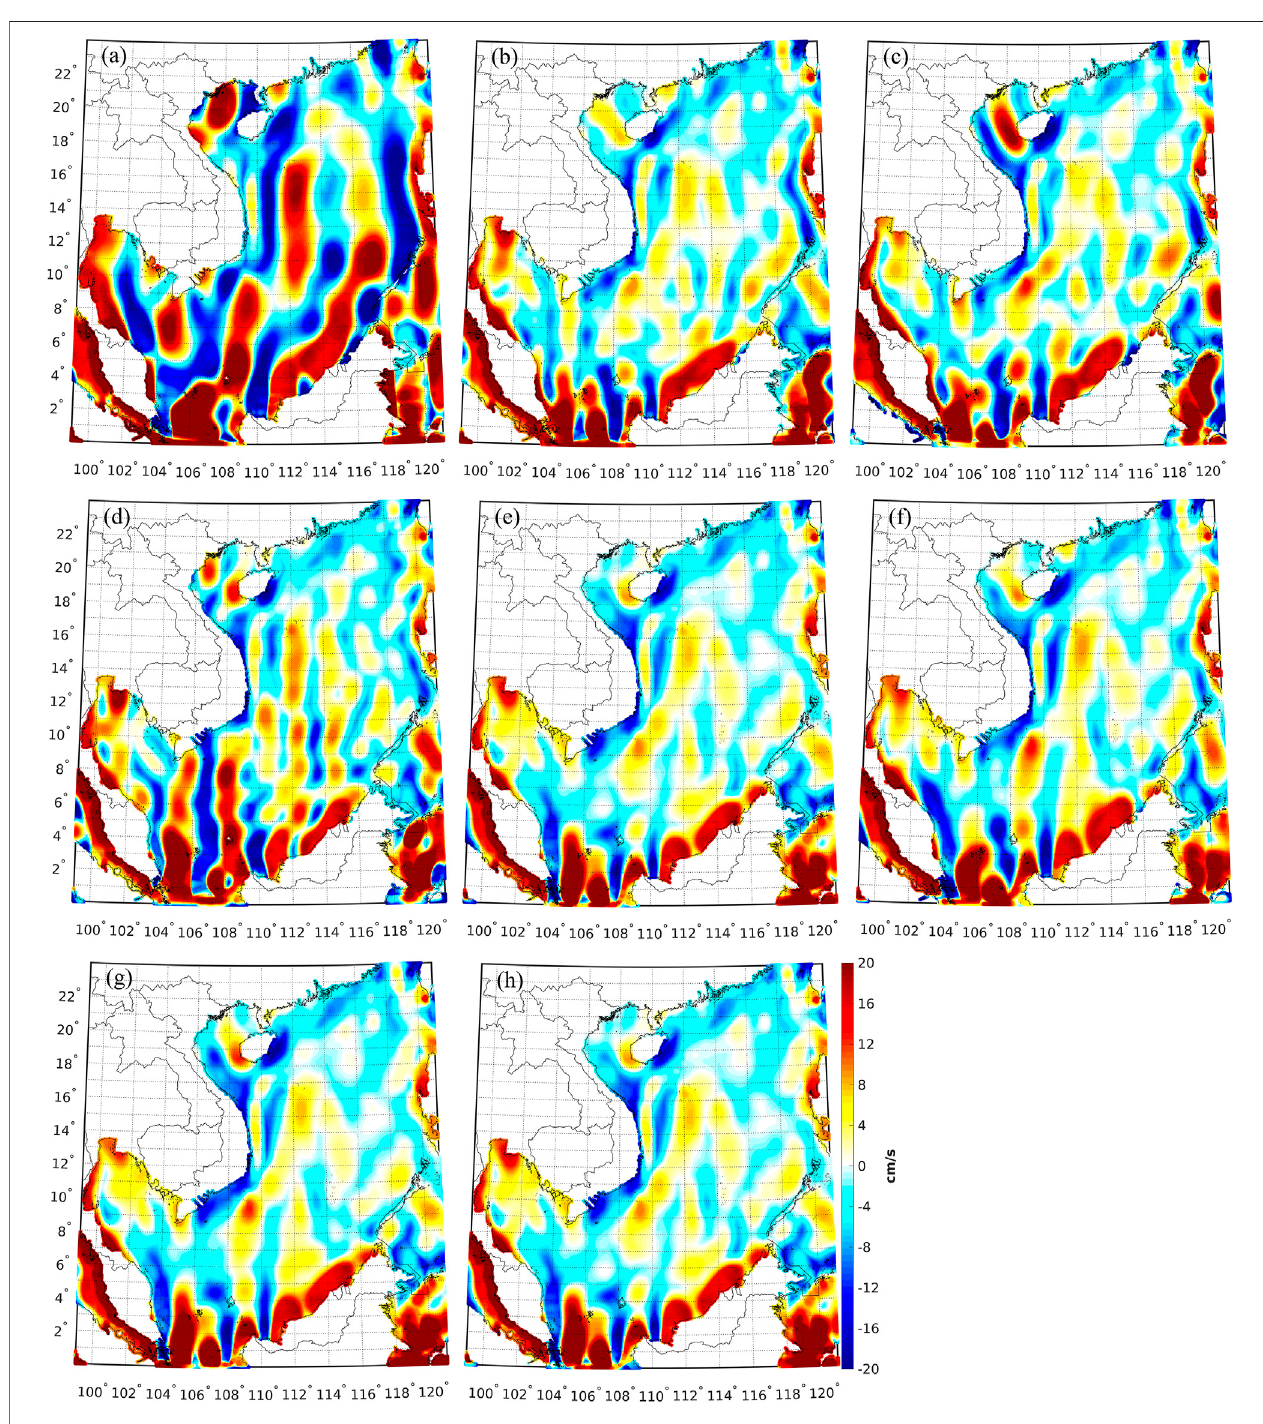
FIGURE 13 | Differences between the meridian velocities computed from the MDT derived from (A) EGM2008, (B) GECO, (C) SGG-UGM-1, (D) EIGEN-6C4, (E) XGM2019e_2159, (F) GOCO05c, (G) XGM2016, (H) XGM2019 and the mean of the meridian velocities derived from all synthetic/ocean data.